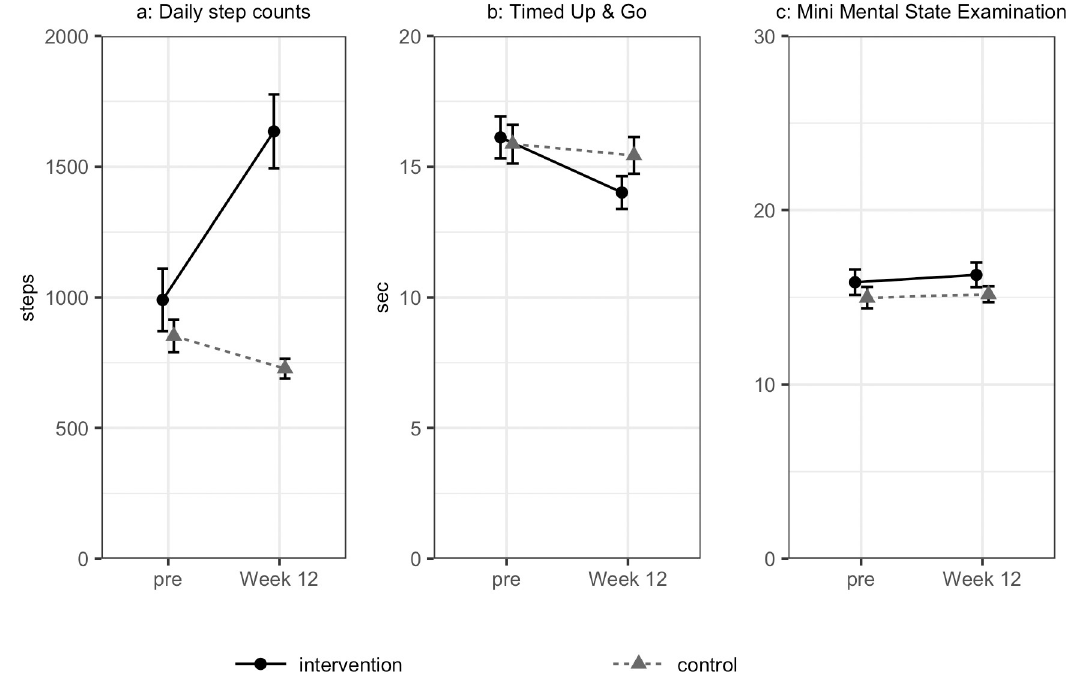
Fig 2. Changes in outcomes: (a) daily step counts; (b) timed up & go and (c) mini-mental state examination.